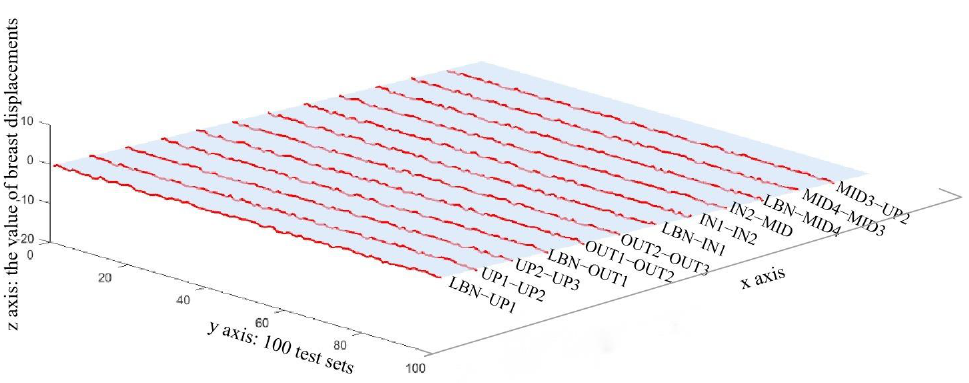
Figure 4. 3D illustration of MAPE result predicted by PSO-BP ANN model.